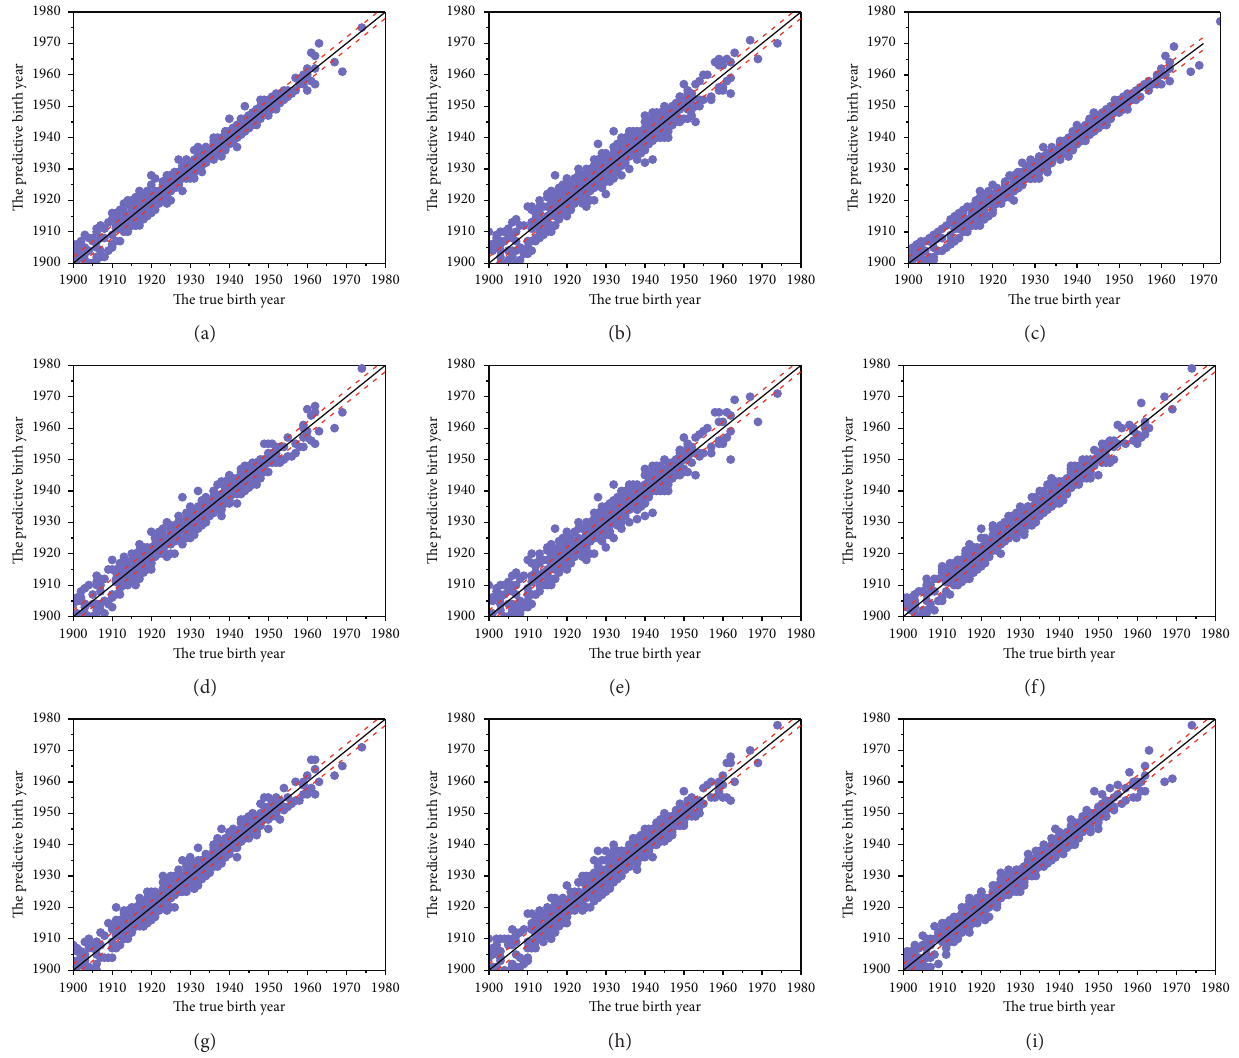
Figure 6: The prediction results under 10% loss of data by SVR, GBDT, and XGBoost. (a) XGBoost S . (b) XGBoost C . (c) XGBoost SC . (d) SVR S . (e) SV R C . (f) SVR SC . (g) GBDT S . (h) GBDT C . (i) GBDT SC